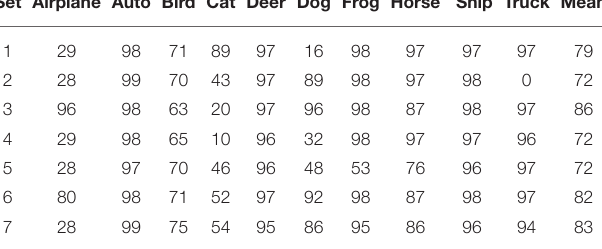
TABLE 1 | Class accuracies. Set Airplane Auto Bird Cat Deer Dog Frog Horse Ship Truck